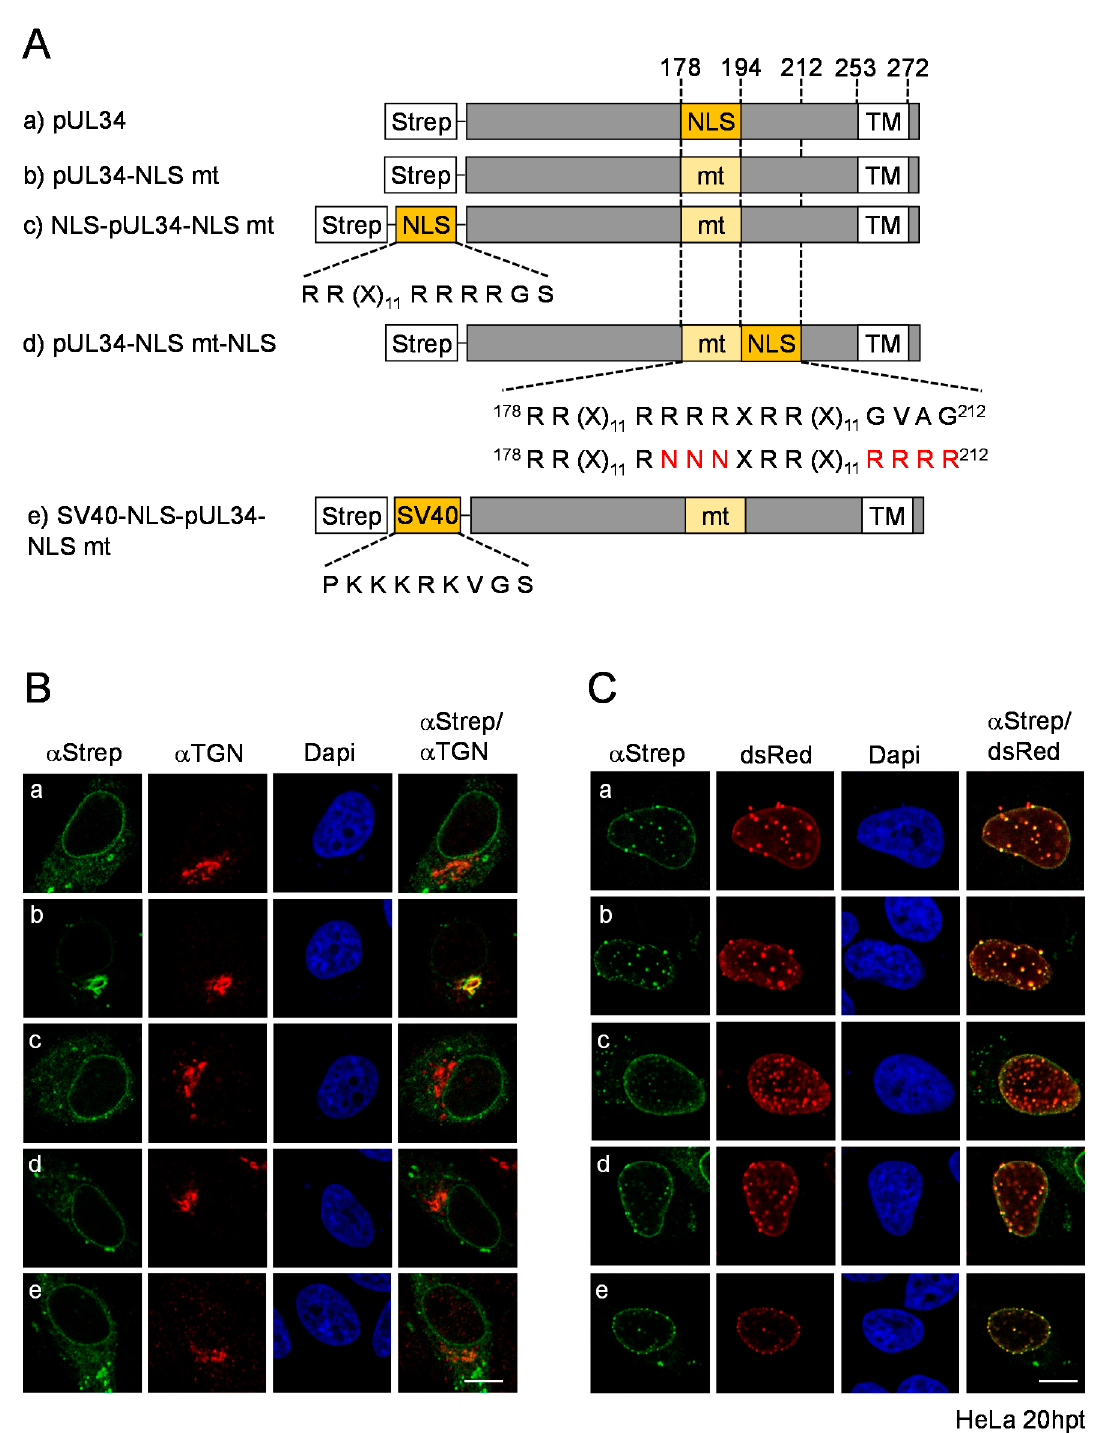
Figure 4. The pUL34-NLS functions independent of its position and can be replaced by an SV40-NLS. ( A ) Graphical depiction of Strep-pUL34, where the pUL34-NLS was replaced by the authentic NLS or a mimic in various positions. ( B , C ): ( a ) Strep-UL34, ( b ) Strep-pUL34-NLS mt, ( c ) Strep-NLS-pUL34-NLS mt and ( d ) Strep-pUL34-NLS mt-NLS as well as ( e ) SV40-NLS-pUL34-NLS mt were expressed in HeLa cells for 20 h either ( B ) alone or ( C ) in combination with dsRed-pUL31. Indirect immunofluorescence was performed using anti-Strep tag II and anti-TGN46 antibodies followed by Alexa Fluor 488- and 555-conjugated secondary reagents. dsRed-pUL31 was visualized directly and nuclei were detected by Dapi. Scale bars correspond to 10 µm.